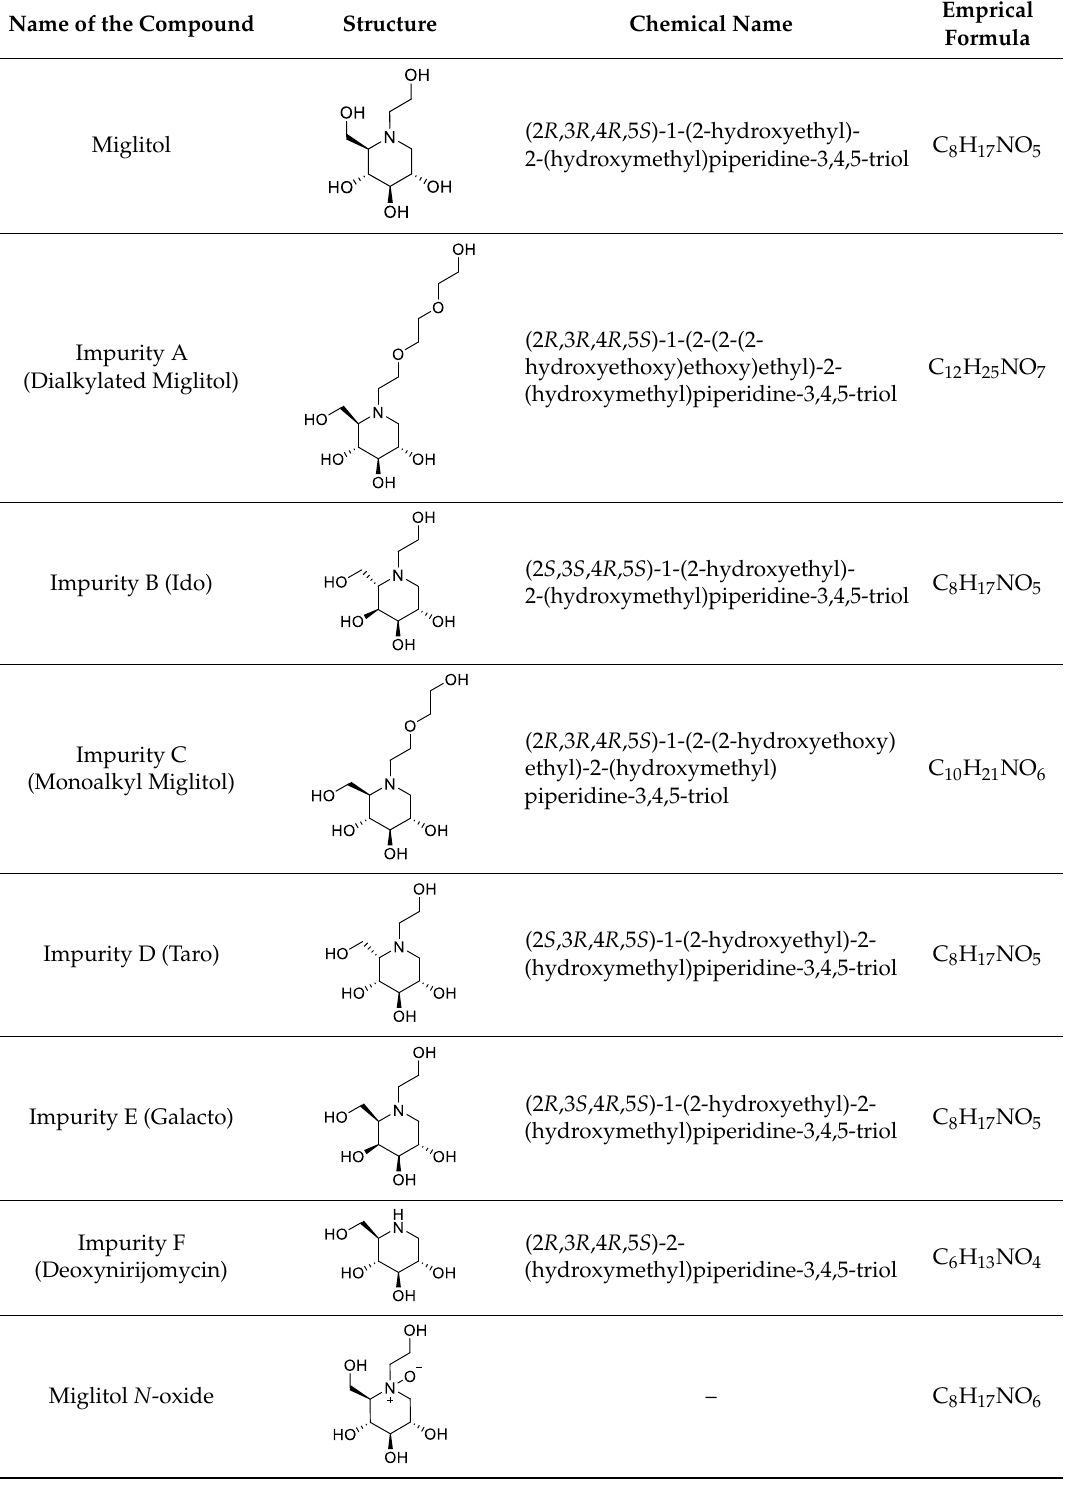
Table 2. Chemical name, structure and decoding list of miglitol and